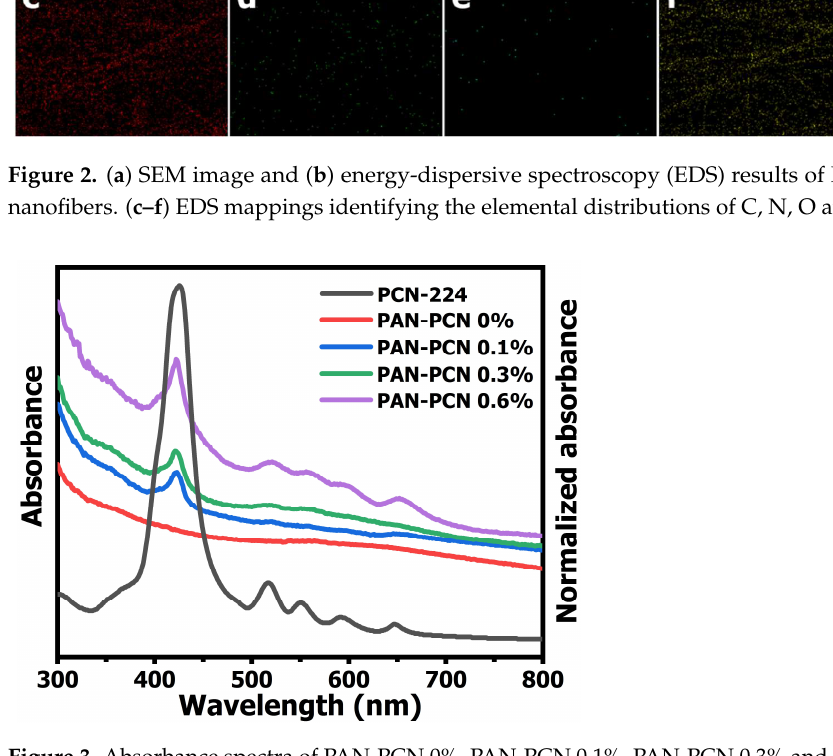
Figure 3. Absorbance spectra of PAN-PCN 0%, PAN-PCN 0.1%, PAN-PCN 0.3% and PAN-PCN 0.6%, as well as normalized absorbance spectrum of PCN-224.